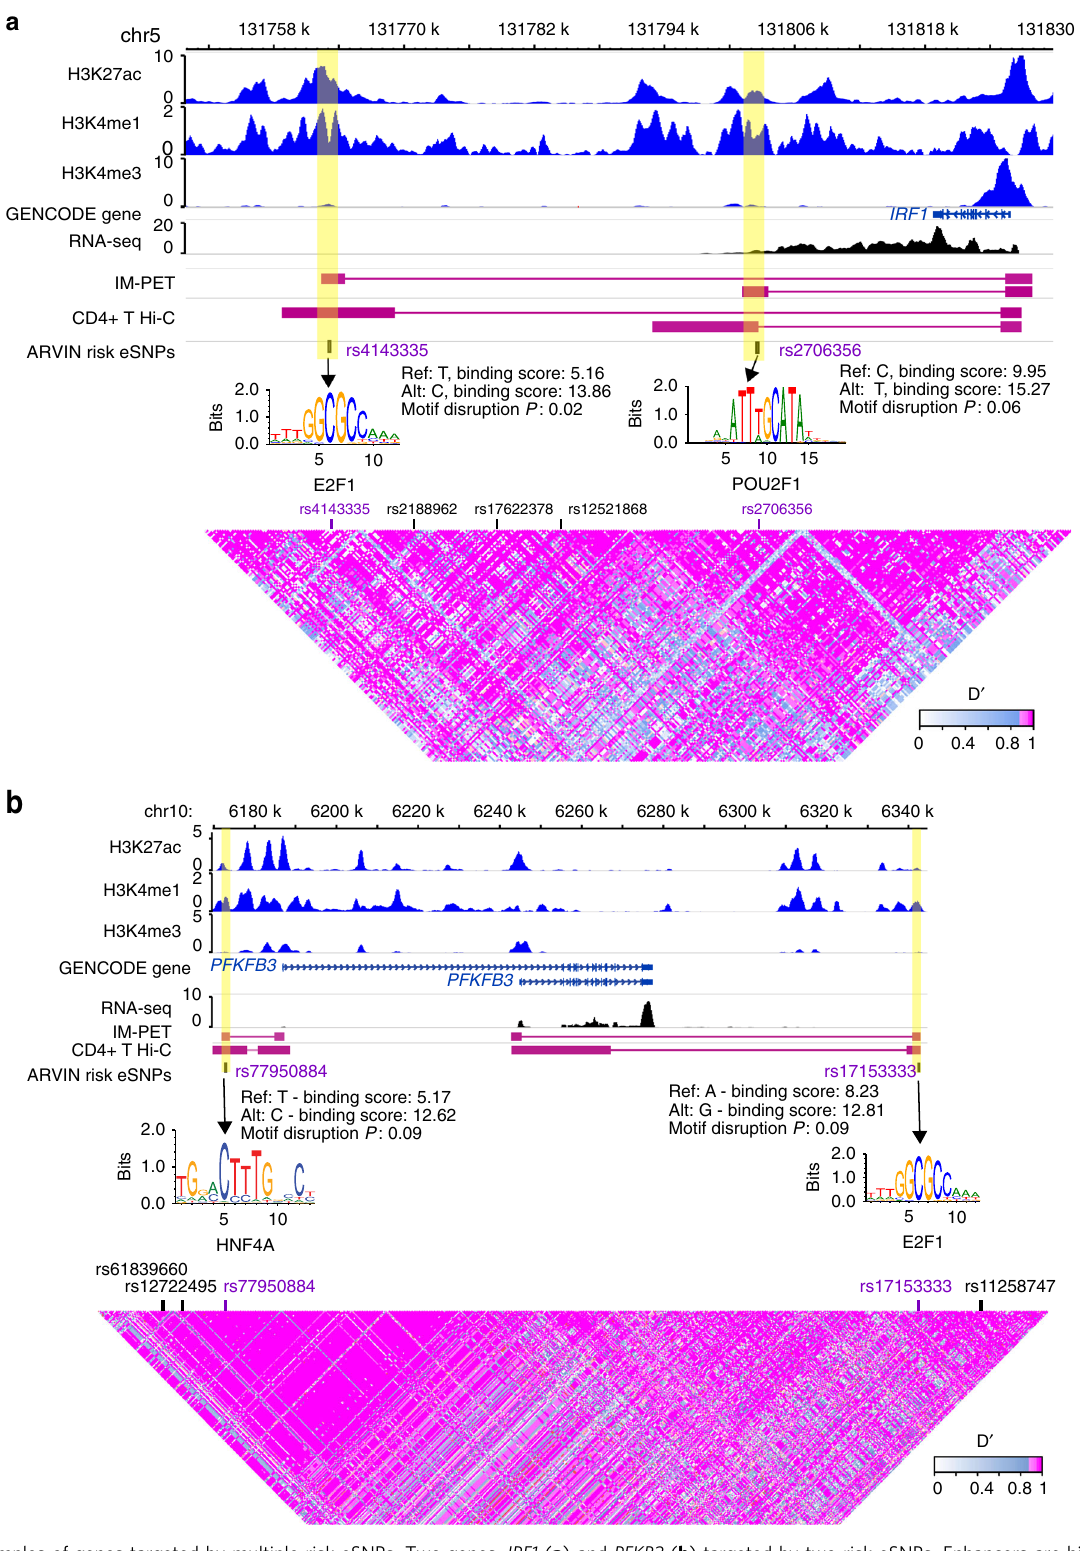
Fig. 6 Examples of genes targeted by multiple risk eSNPs. Two genes, IRF1 ( a ) and PFKB3 ( b ) targeted by two risk eSNPs. Enhancers are highlighted in yellow shade. IM-PET, enhancer − promoter interactions predicted by IM-PET. CD4 + T Hi-C, enhancer − promoter interactions detected by Capture Hi-C data. Annotation for autoimmune disease-associated loci is based on